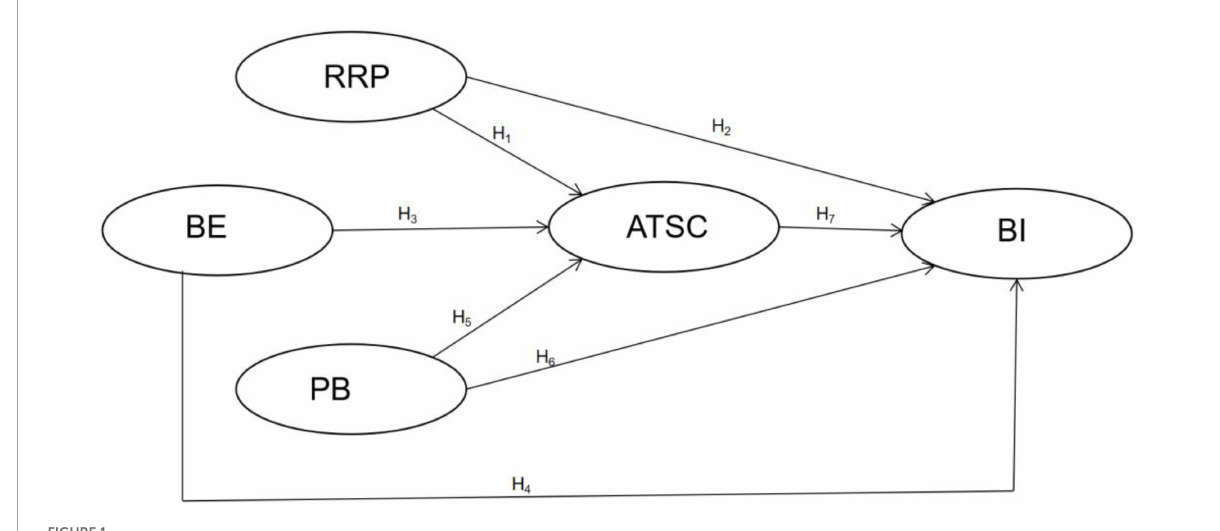
FIGURE1 The research model. RRP, reduced risk perception; BE, benign envy; PB, perceived benefits; ATSC, attitude toward staycations; BI, behavioral